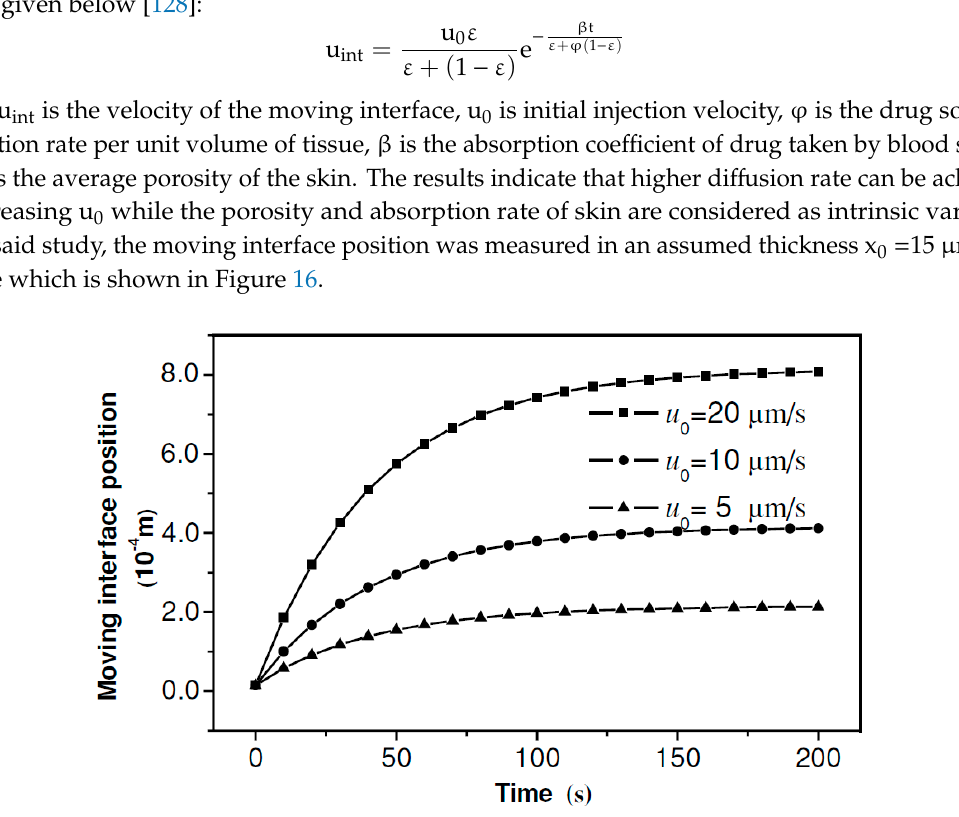
Figure 16. Influence of injection velocity on the position of the moving interface ( ε = 0.2, φ = 0.01 m 3 liquid/m 3 tissue, β = 0.005 m 3 liquid/m 3 tissue/s) (adopted from [128]).